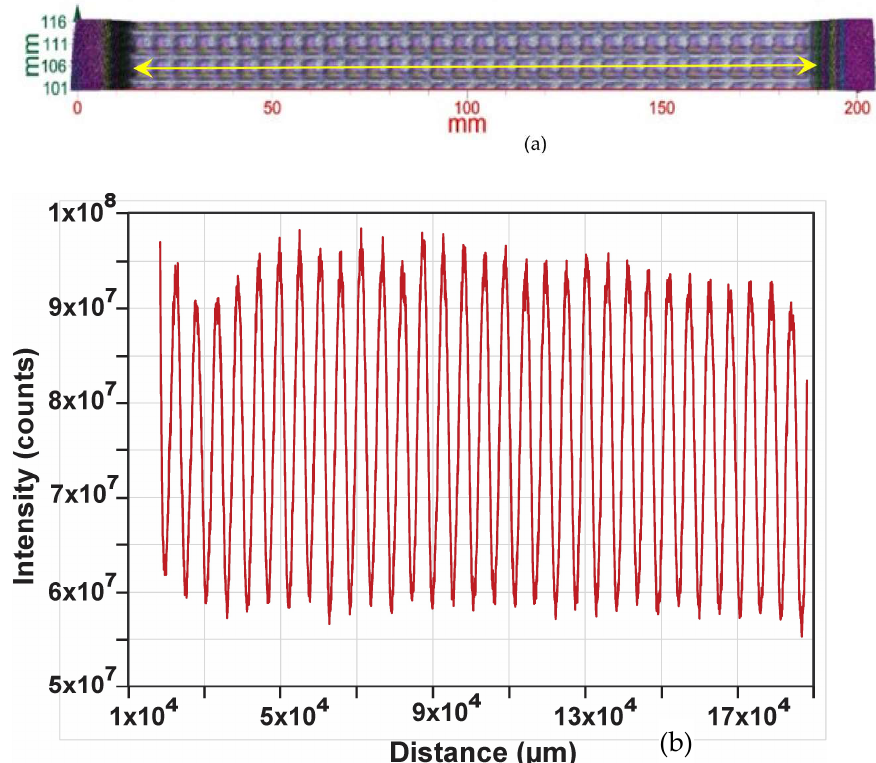
Figure 5. ( a ) shows 2 full rows of dies on the wafer shown in Figure 3, and ( b ) shows the scanned profile of 1 row at Y = 110 mm (i.e., around mid-point), as indicated by the yellow line in ( a ).